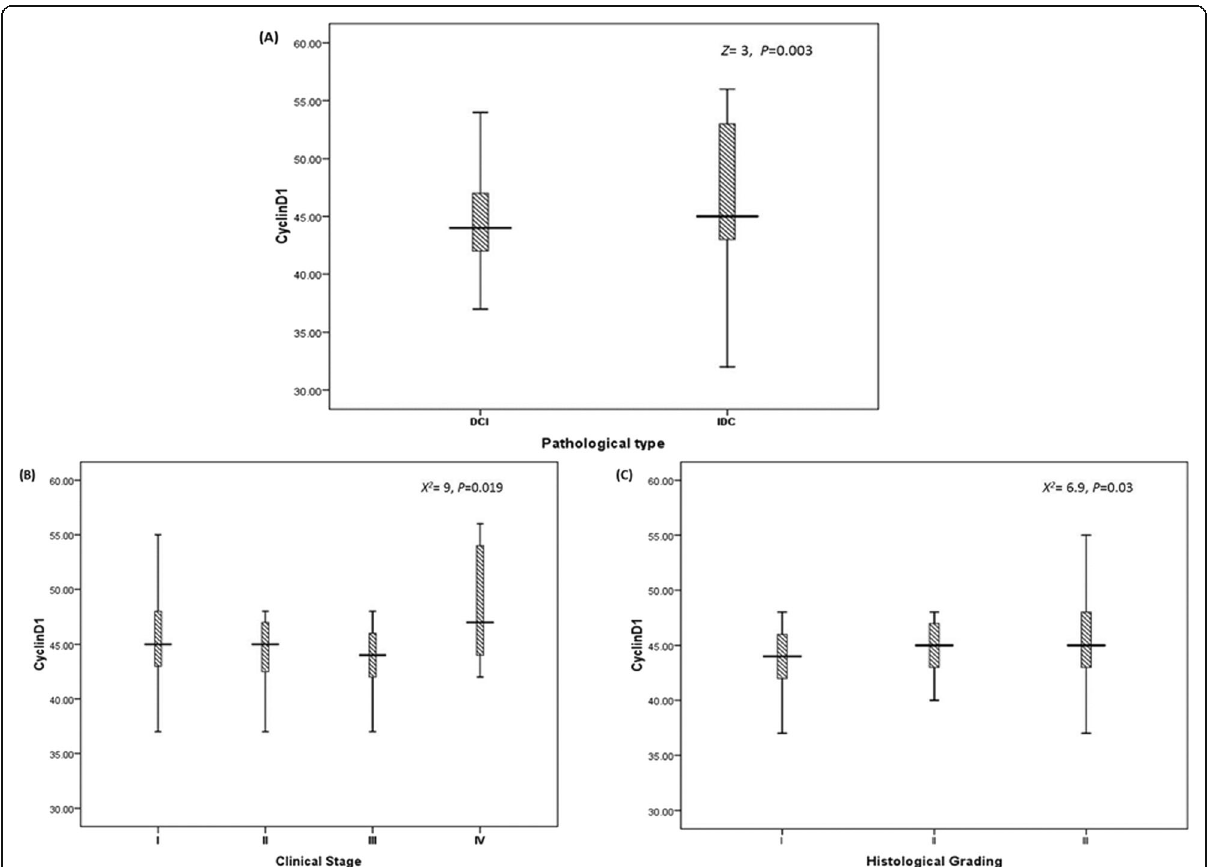
Fig. 4 Relation between cyclin D1 and clinico-pathological features. a Pathological types (DCI vs IDC) at Z =3 ( P =0.003). b Clinical stages (stage I to IV) at X 2 =9 ( P =0.019). c Histological grading (grade I to III) at X 2 =6.9 ( P =0.03). Statistical analysis was done using the non-parametric test; as for two variables, the Mann-Whitney U test ( Z -value) was used; and for more than two variables, the Kruskal-Wallis H test ( X 2 test) was